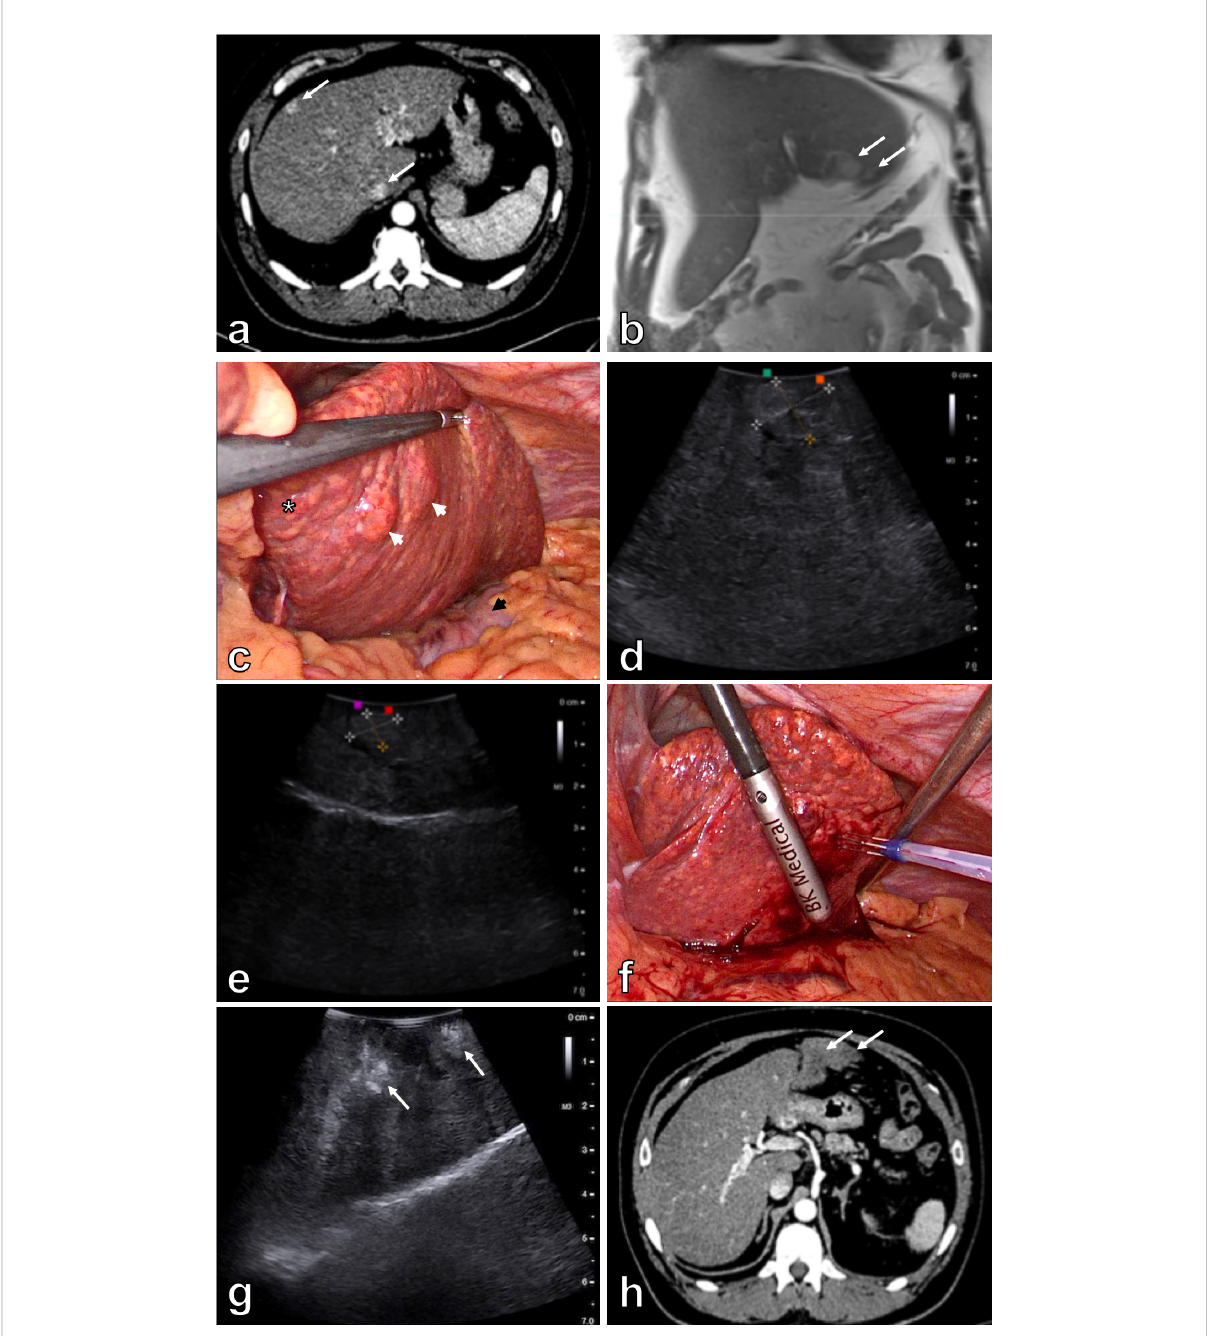
FIGURE 2 Patient 2. Initial contrast enhanced abdominal CT demonstrates multiple hypervascular lesions (white arrows) in the cirrhotic liver (A) . Contrast enhanced MRI of the liver after 24 cycles of immunotherapy demonstrates 18 mm and 8 mm lesions (white arrows) in segment III of the liver (B) . Laparoscopy shows macronodular liver cirrhosis (asterisk). Both tumors (white arrowheads) are seen after the retraction of the left liver lobe. Notice the stomach just underneath the left liver lobe (black arrowhead) (C) . Intraoperative US better demonstrates a larger 20 x 15 mm tumor (D) and a smaller 8 x 12 mm tumor in the segment III (E) . Electric pulses to the tumor are applied through convergent Stinger electrode. Placement of the electrode is aided by intraoperative US (F) . Control intraoperative US immediately after the treatment demonstrates areas of avital lesions (white arrows) (G) . Contrast enhanced abdominal CT three months after the procedure demonstrates 22 mm and 10 mm avascular lesions (white arrows) in segment III of the liver (H)